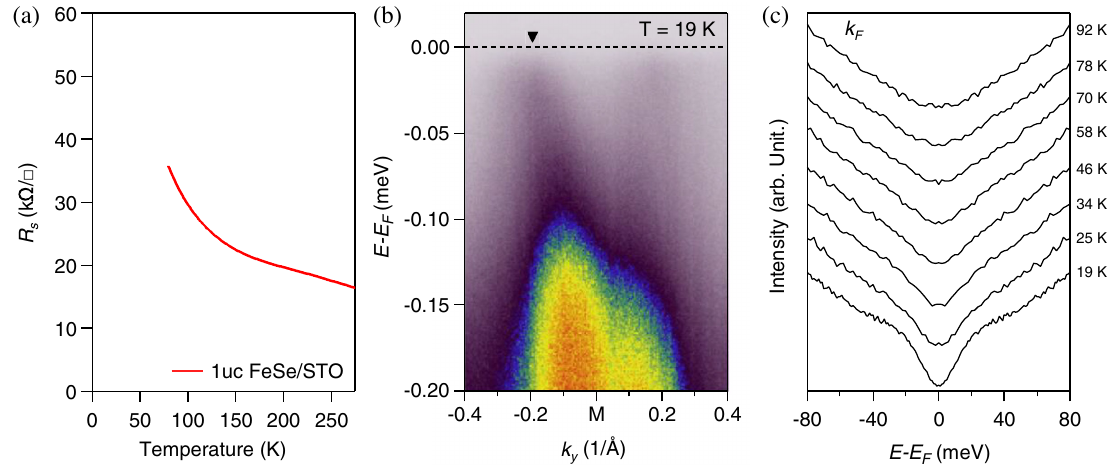
FIG. 8. ARPES behavior of insulating single-layer FeSe = SrTiO 3 . (a) In situ R s ð T Þ data for an insulating single-layer FeSe = SrTiO 3 film. (b) ARPES spectra taken at M at T ¼ 19 K. (c) Temperature-dependent symmetrized EDCs at k F as indicated by the arrow in